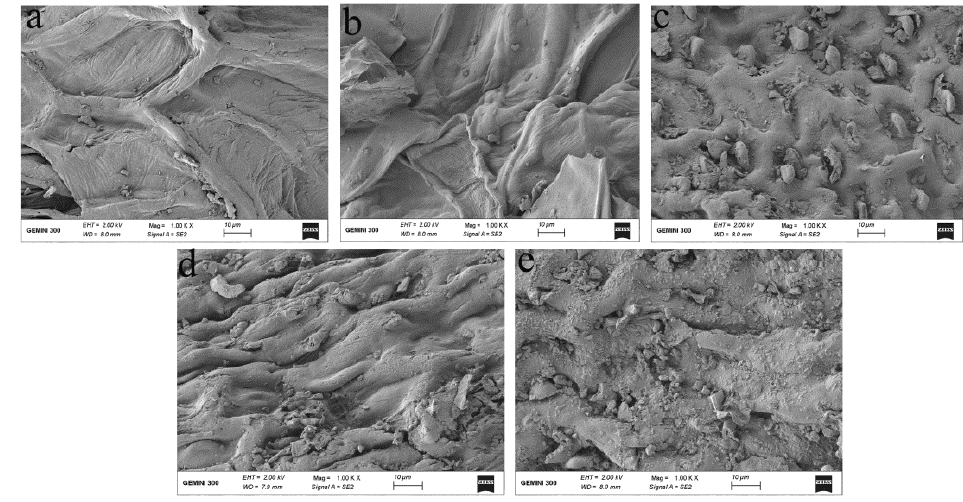
Figure 5. Scanning electron micrographs of LSP before ( a ) and after extraction with four different treatments (WW ( b ), WG ( c ), UW ( d ), and UG ( e )).